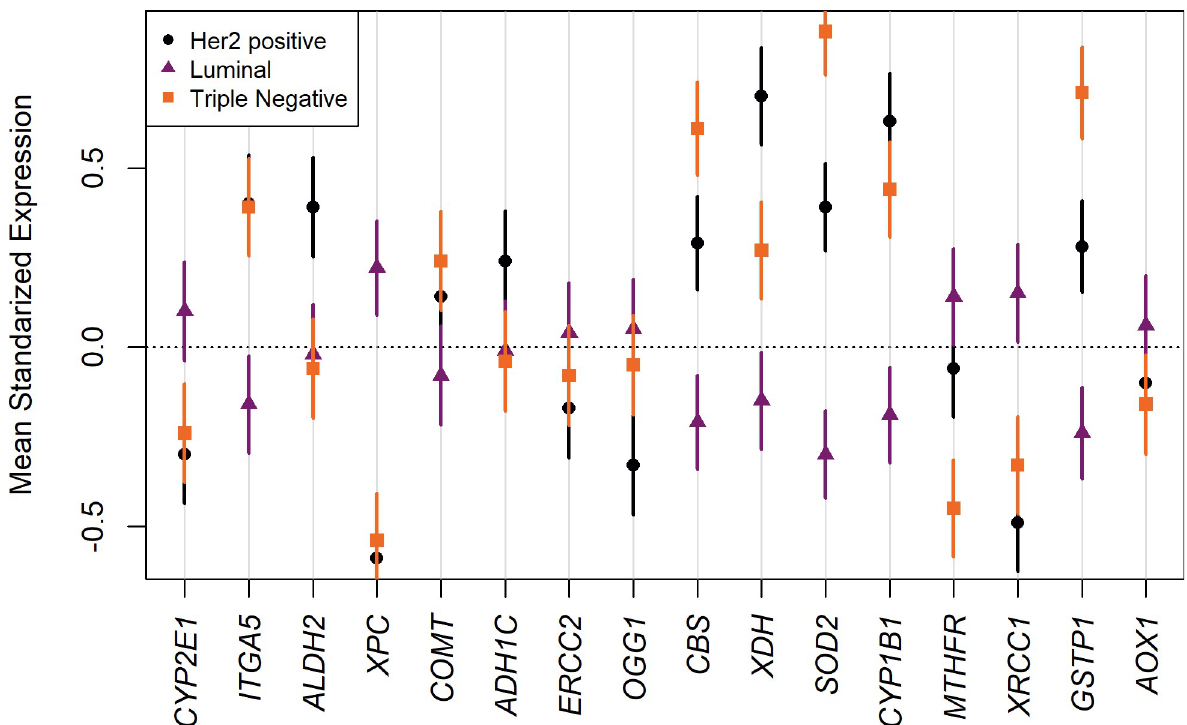
Fig 2. Target genes mean expression by cancer subtype. Bonferroni intervals were obtained considering the total number of pair-wise comparisons among all genes in the datasets. Intervals for alcohol related genes are plotted around the mean expression by cancer subtype.